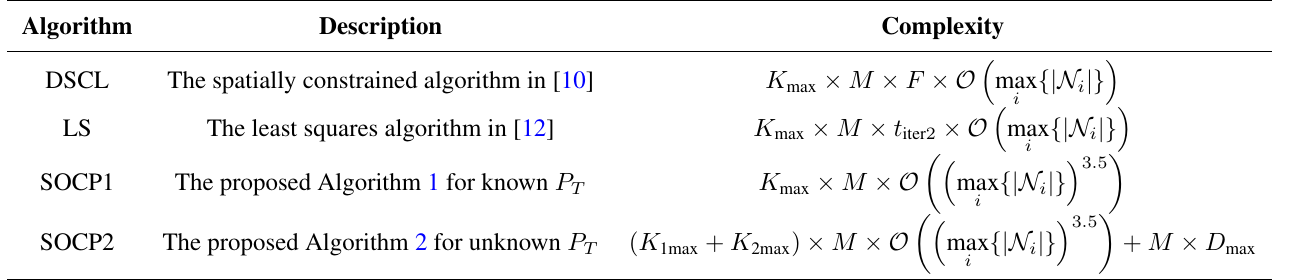
Table 1. Summary of the considered